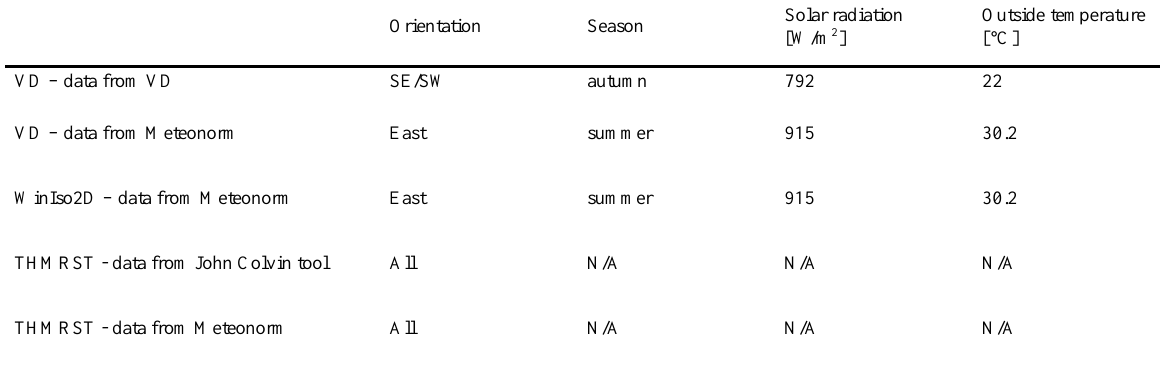
Table 4: THE MOST CRITICAL CLIMATIC DATA FOR PANE 2 for max. temperature